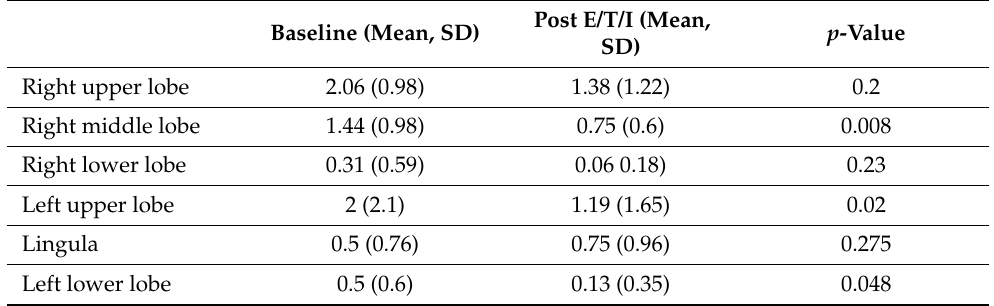
Table 3. Structural Improvement by lobe of lung.